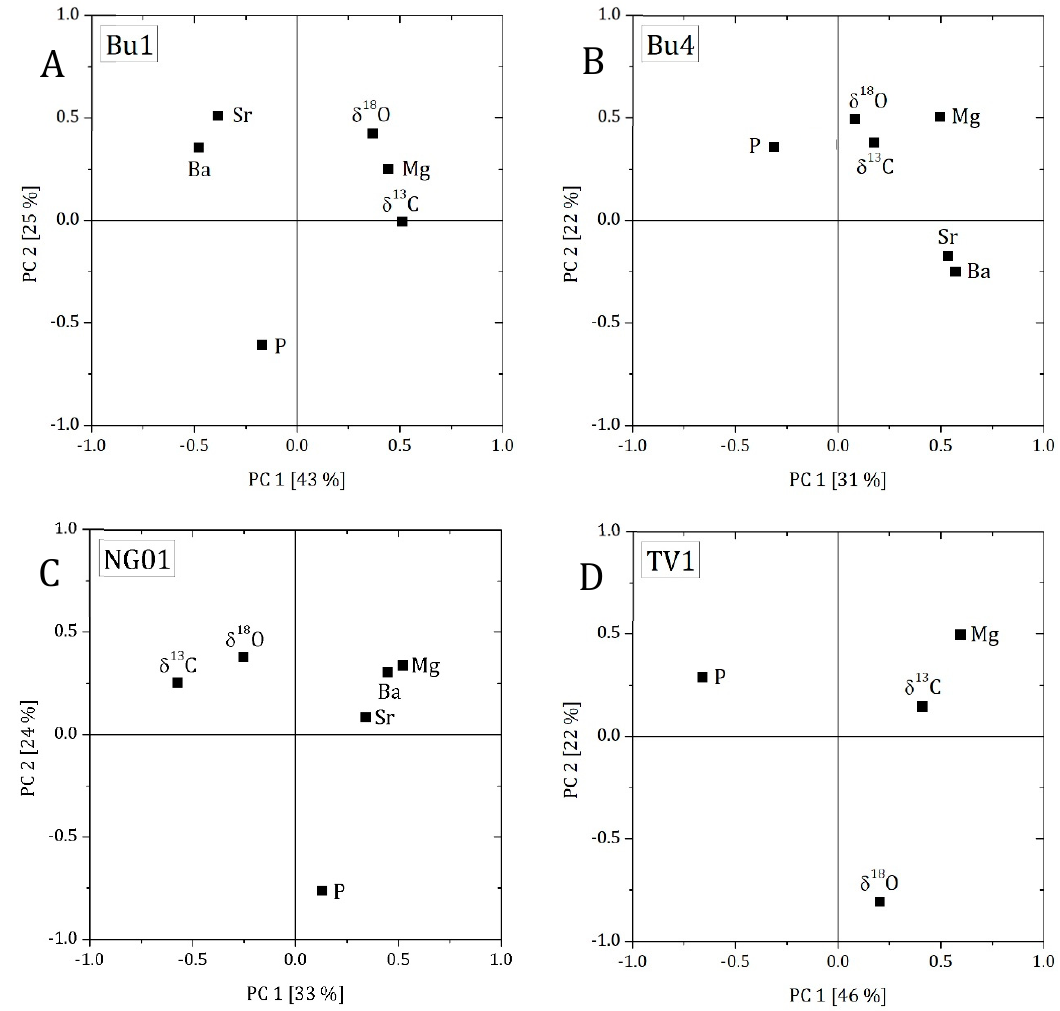
Figure 8. Results of the principal component analysis (PCA) of stalagmites Bu1 ( A ) and Bu4 ( B ) from Bunker Cave as well as NG01 ( C ) and TV1 ( D ) from the Herbstlabyrinth cave system.